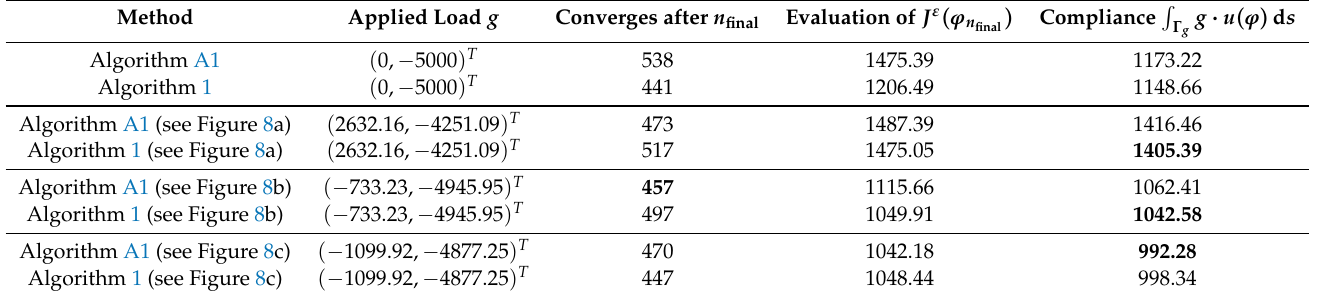
Table 3. Comparison of metrics between Algorithms A1 and